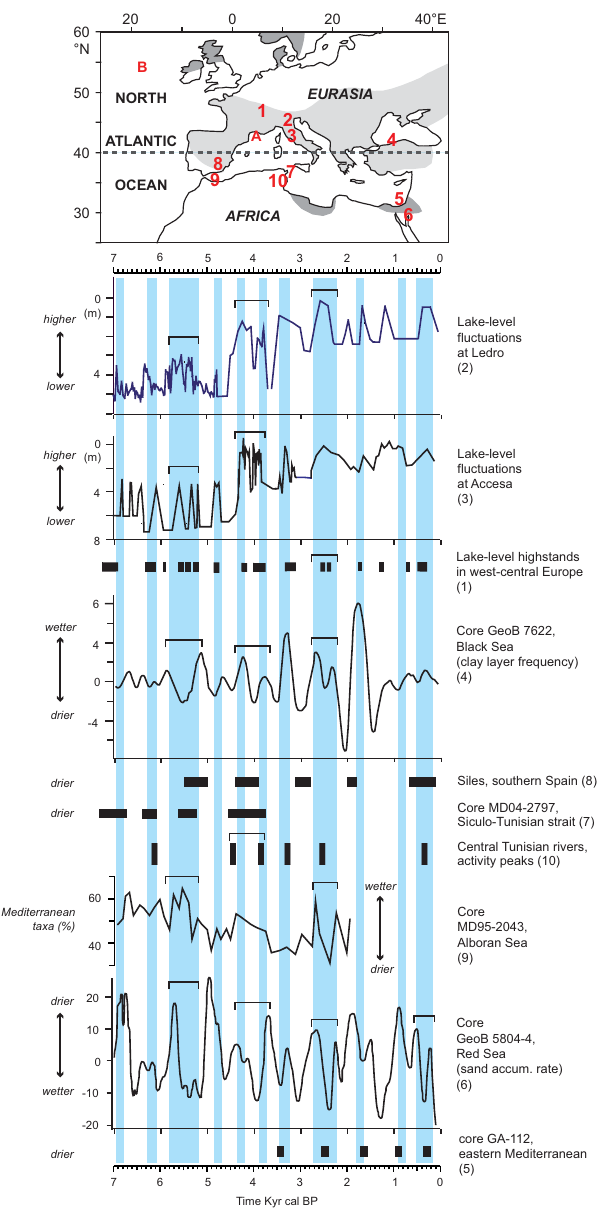
Fig. 9. (Top) Location of records used in the lower panel (1 to 10) or cited in the text ( A and B ). (1) lake-level record from west-central Europe (Magny, 2013); (2) Lake-level record from Lake Ledro (Magny et al., 2012b); (3) Lake-level record from Lake Accesa (Magny et al., 2007); (4) core GeoB7622 (Lamy et al., 2006); (5) core GA-112 (Schilman et al., 2001); (6) core GeoB5804-4 (Lamy et al., 2006), (7 , 8 and 9) pollen records from core MD04-2797 (Desprat et al., 2013), from Siles (Carri´on, 2002), and from core MD95-2043 (Fletcher et al., 2013), respectively; (10) central Tunisian rivers (Ziehlhofer and Faust, 2008). (A) record of storm frequency from a lagoonal sediment sequence in the Gulf of Lions (Sabatier et al., 2012); (B) IRD record from the North Atlantic Ocean (Bond et al., 2001). The present day areas affected by increasing (decreasing) humidity in response to positive (negative) NAO are represented by dark (light) grey zones (from Lamy et al., 2006; Marshall et al., 2001). (Bottom) Centennial-scale hydroclimatic changes around the Mediterranean basin during the last seven millennia. The numbers in brackets after the names of the sites on the right-hand side of the figure refer to the points located on the map in the upper panel. The Ledro, Accesa and west-central Europe lake-level records are from Magny et al. (2007, 2012b) and from Magny (2013); the records from cores GeoB 7622 and GeoB 5804-4 are from Lamy et al. (2006); the record from Siles is from Carri´on (2002); the record from core MD04-2797 is from Desprat et al. (2013), that from central Tunisian rivers is from Ziehlhofer and Faust (2008); the record from core MD95-2043 is from Fletcher et al. (2013); and the record from core GA-112 is from Schilman et al. (2001). Horizontal brackets point out a possible complexity of events (see discussion in the